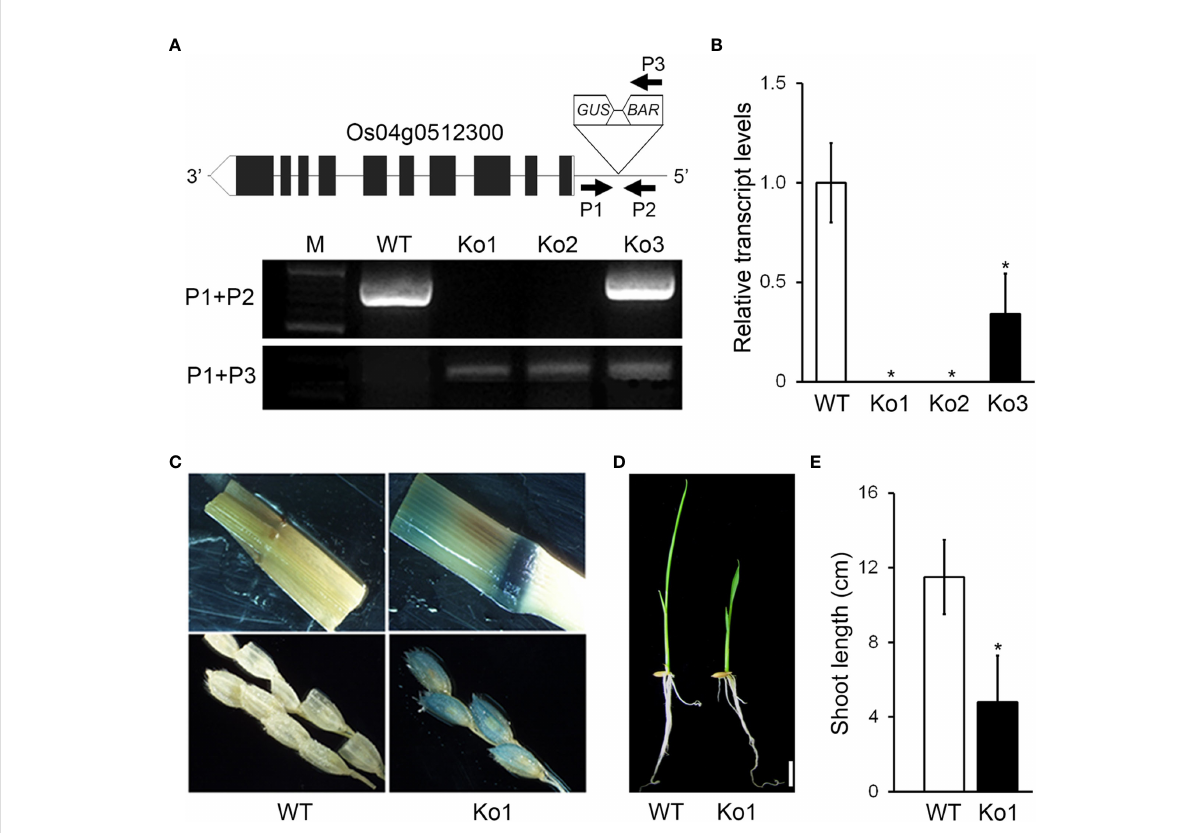
FIGURE 1 Identi fi cation and characterization of osgasd knockout mutant plants. (A) Diagram of osgasd knockout mutant (Ko) with the position of the inserted T-DNA (triangle) in the Os04g0512300 gene. Gene-speci fi c (P1 and P2) and T-DNA left border (P3) primers used for PCR genotyping. WT indicates non-transgenic wild-type plants lacking a T-DNA insertion (PCR products ampli fi ed by only P1+P2). PCR products ampli fi ed with the indicated P1+P3 primer sets and both P1+P2 and P1+P3 were homozygous and heterozygous plants, respectively. M, DNA size marker. (B) RT-qPCR analysis showing transcript levels of OsGASD in the WT plant or osgasd mutants. Error bars indicate SD. OsActin1 (Os03g0718100) was used as an internal control and relative expression levels are shown in fold values. Asterisks indicate statistically signi fi cant differences between the corresponding samples and their control (p-value<0.1, Student ’ s t-test). Lines 1 (ko1) was used in this study. (C) Analysis of GUS staining in panicles neck node and spikelet of WT and osgasd knockout mutant which is carrying the P35S::GUS transgenes. (D, E) Comparison of shoot length in wild-type and osgasd knock mutant (Ko1). (D) Growth of wild-type plants and Ko1 mutants grown on MS media for 10 days (Scare bar = 1